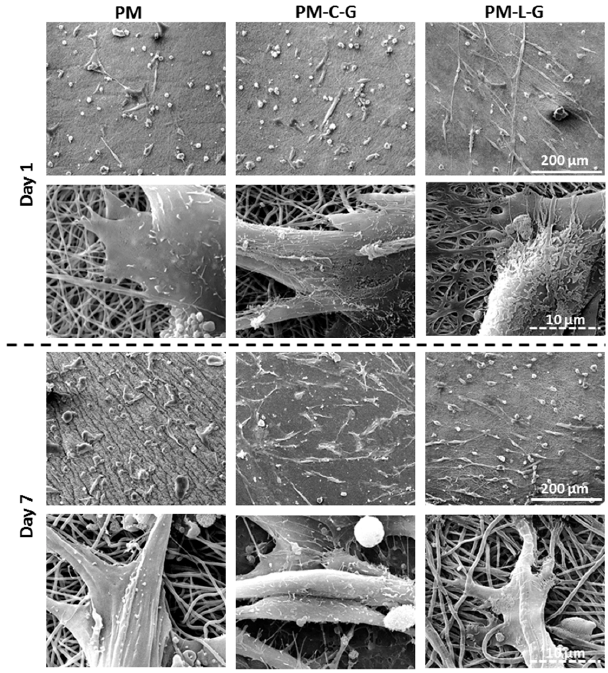
Figure 6. Scanning electron micrographs showing cell morphology at low and high magnification.